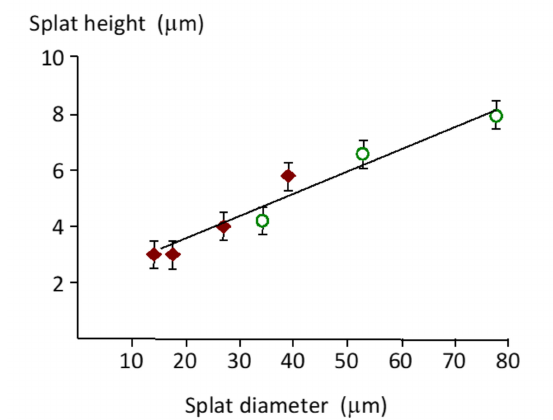
Figure 6. Variation of splat height (h) with splat diameter (d), according to the line of best fit, h = 0.083d + 1.743 (R 2 = 0.98) in the splat size range of 15 µ m to 80 µ m. Data with diamond symbols were sourced from the coating made from 20–40 µ m particles, and the data with open circles came from the coating made from 40–60 µ m